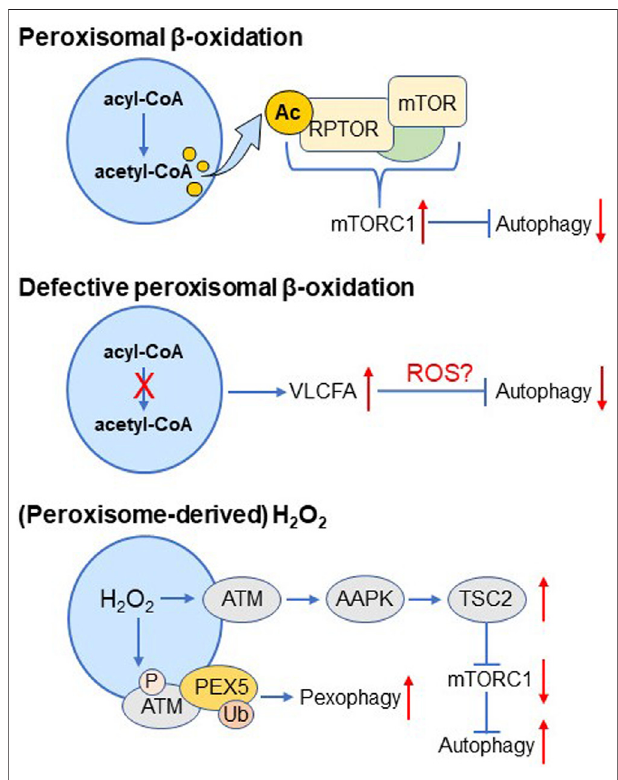
FIGURE 4 | The peroxisome-autophagy signaling